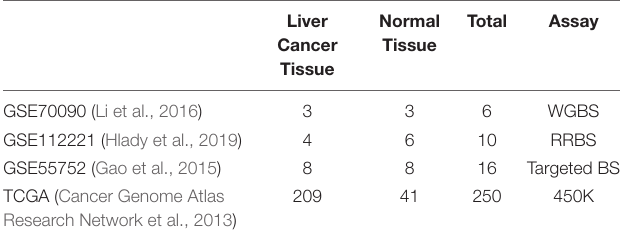
TABLE 5 | Statistic of datasets in experiment.